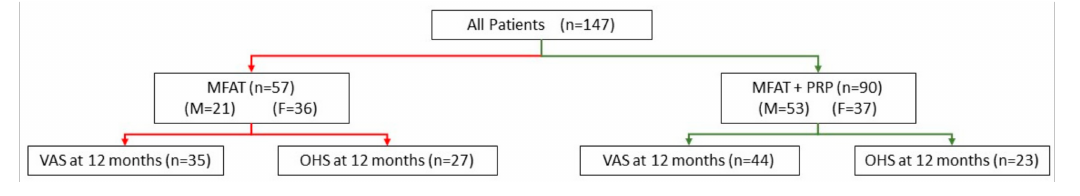
Figure 3. Study flow chart.